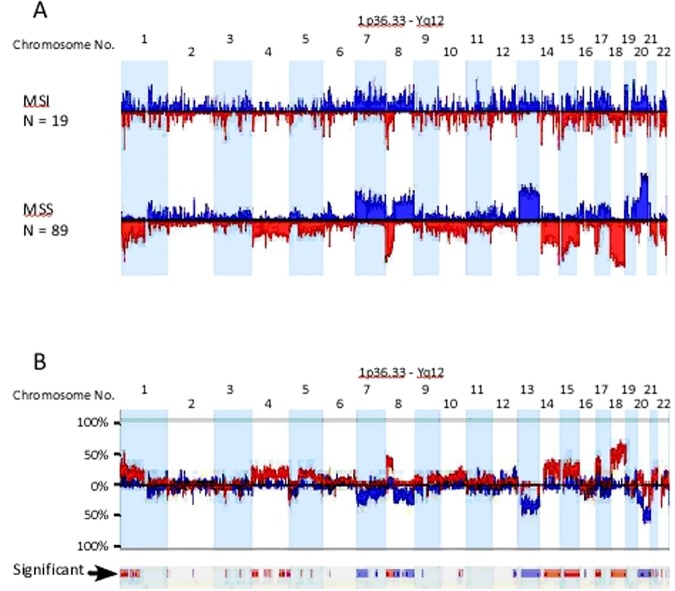
Genomic aberrational differences between MSS and MSI CRC.a) Shows histogram profiles of the autosome from 19 MSI and 89 MSS CRC. Deviations up from 0% represent copy number gains and are colored blue, while deviations below the 0% line represent copy number losses and are colored red. b) Genomic aberrations frequency (or %) differences between MSS and MSI CRC. The significant differences are displayed as bars in the significance row marked with black arrow. Blue bars deviating below 0% indicates significantly more frequent gains in MSS compared to MSI CRC, while blue bars deviating above 0% represent more frequent gains in MSI compared to MSS (e.g. chromosome arm 12q). Similarly, red bars deviating above 0% indicates significantly more frequent losses in MSS compared to MSI CRC, while red bars deviating below 0% represent more frequent losses in MSI compared to MSS (e.g. chromosome 3p).